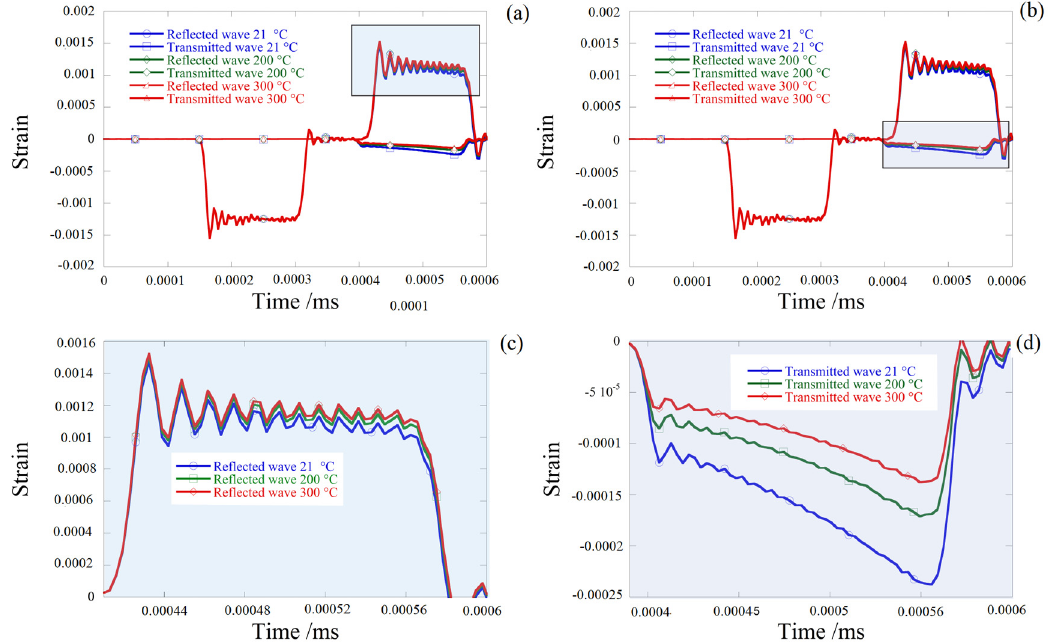
Figure 12. Comparison of reflected and transmitted waves under different temperatures (cylinder sheet). ( a , b ) reflected and transmitted waves ( c ) reflected strain waves and ( d ) transmitted strain waves.